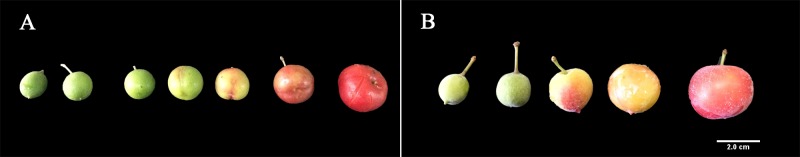
C. humilis (A: 8, 10, 12, 14, 16, 18, and 19 weeks after flowering) and C. glandulosa (B: 8, 10, 12, 13, and 14 weeks after flowering) fruits at different developmental stages.